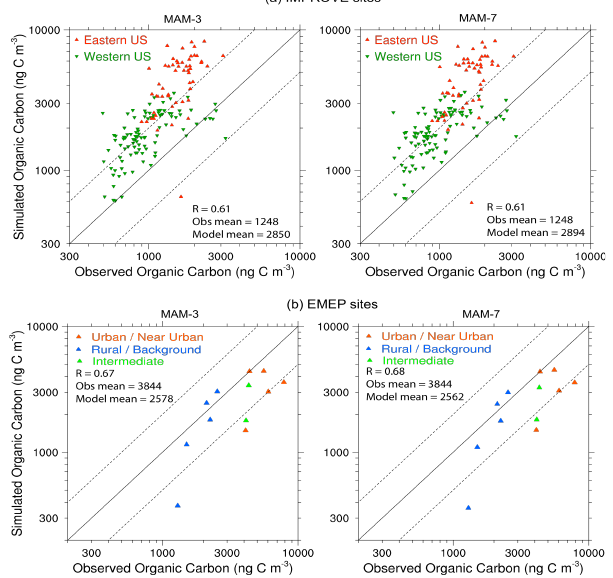
Figure 12. Observed and simulated annual-average organic carbon (OC) concentrations (ng C m -3 ) at IMPROVE and EMEP BC/OC network sites. Observations are for site- available years between 1995-2005 for IMPROVE sites and July 2002 – June 2003 for EMEP sites. Simulated values for MAM3 (left) and MAM7 (right) are from model lowest layer and are equal to the modeled (POM + SOA)/1.4. Top: IMPROVE network, Eastern U.S. sites are east of 97 W longitude. Bottom: EMEP network.